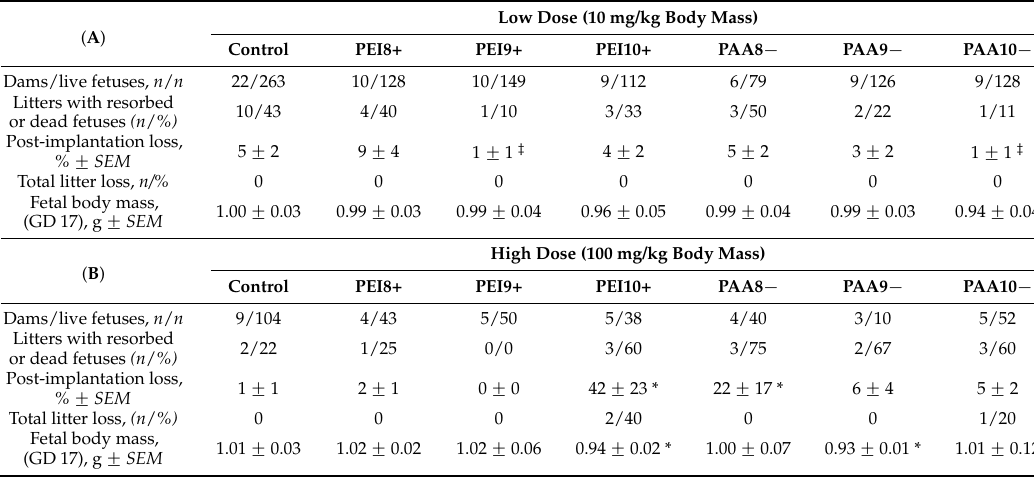
Table 3. Fetal parameters following cesarean on GD 17 for dams treated with 10 mg/kg ( A ) or 100 mg/kg ( B ) of iron oxide NPs on GD 8, 9, or 10. * Significant difference between treatment and control ( p < 0.05). ‡ Trend between treatment and control at ( p < 0.1).